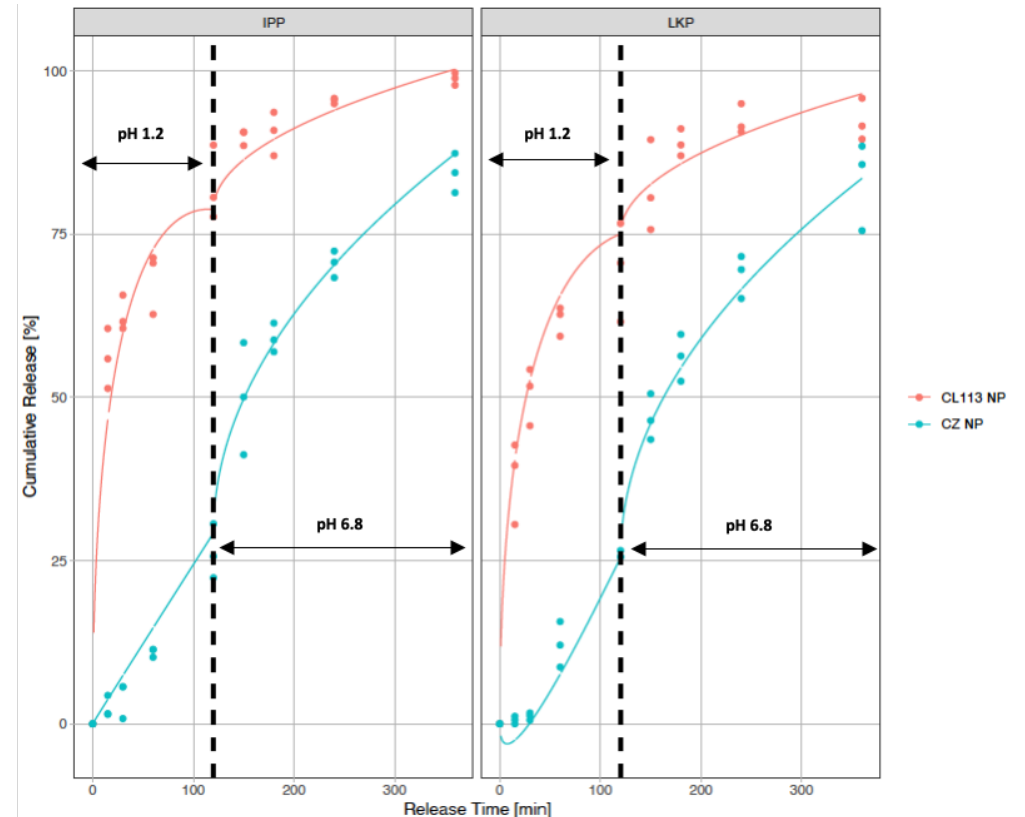
Figure 8: Release kinetics of IPP/LKP NPs and IPP/LKP CZ NPs. Data is expressed as n Figure 8. Release kinetics of IPP/LKP NP and IPP/LKP CZ NP. Data is expressed as n = 3. = 3. Table 4. Swellable Peppas model parameters for kinetic release studies of CL113 nanoparticles loaded with LKP and IPP. Where IPP and LKP both represent uncoated control formulations in ks (stomach compartment) and ki (intestinal compartment) divided into diffusion and relaxation mechanisms (1 and 2). All parameters listed were statistically significant